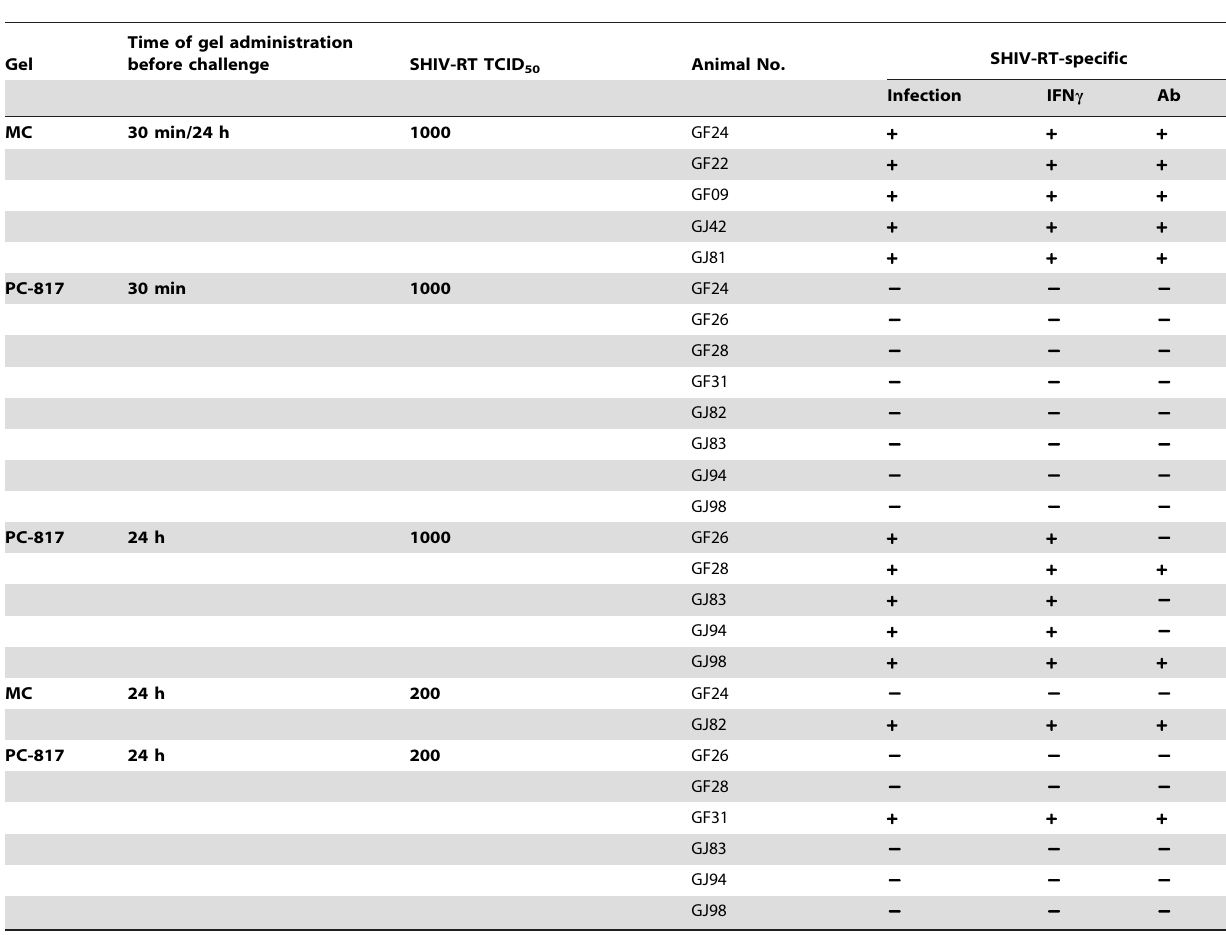
Table 2. 30 minute pretreatment with PC-817 prevents vaginal SHIV-RT infection in HSV-2-infected macaques.